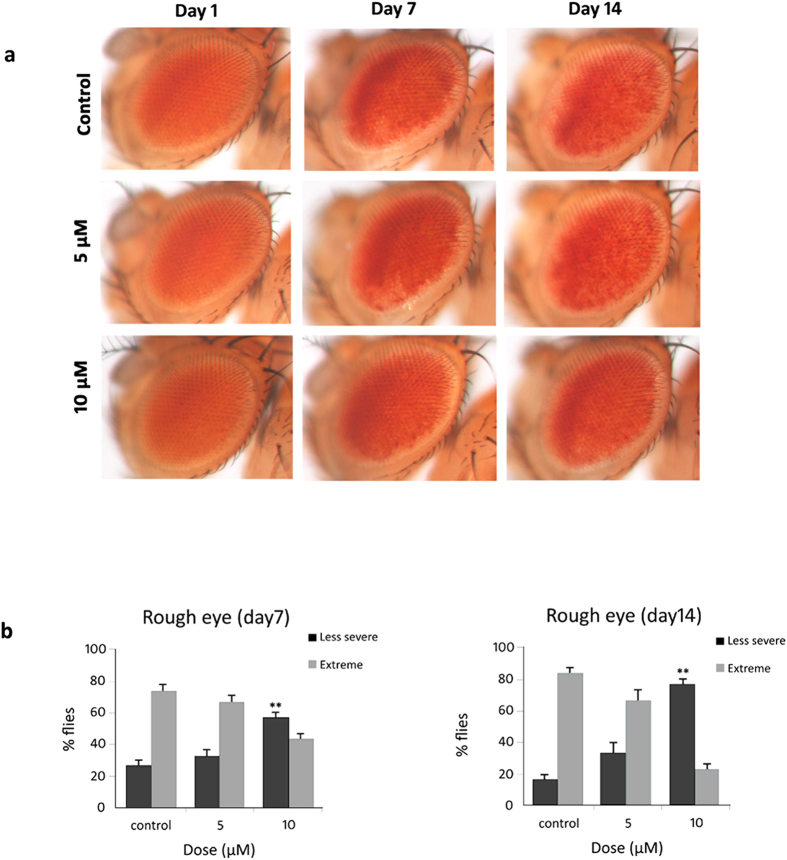
Dietary supplement of curcumin suppresses polyQ-induced rough eye phenotype and loss of pigmentation.(a) Images of external eye surface of 1-day, 7-day and 14-day old flies expressing Httex1p Q93 driven by gmr-GAL4 reared on normal food (top panels), 5 μM (middle panels) and 10 μM (bottom panels) curcumin-containing food. Dietary curcumin mediated attenuation of polyQ-induced degeneration and pigment loss indicative of cytotoxicity is evident at days 7 and 14 post-eclosion. (b) Administration of 10 μM curcumin suppressed rough eye phenotype and pigment loss at days 7 (left panel) and 14 (right panel). The frequency of necrotic lesions in the fly eye was evaluated by considering less severe phenotype as 0–4 necrotic lesions and extreme phenotype as >4 necrotic lesions. Data represents the mean ± SEM of values obtained from 30 flies per condition (n = 30); **p < 0.01 compared with control. Data was analyzed using the Kruskal-Wallis test followed by Mann-Whitney test with Bonferroni correction of p-values.